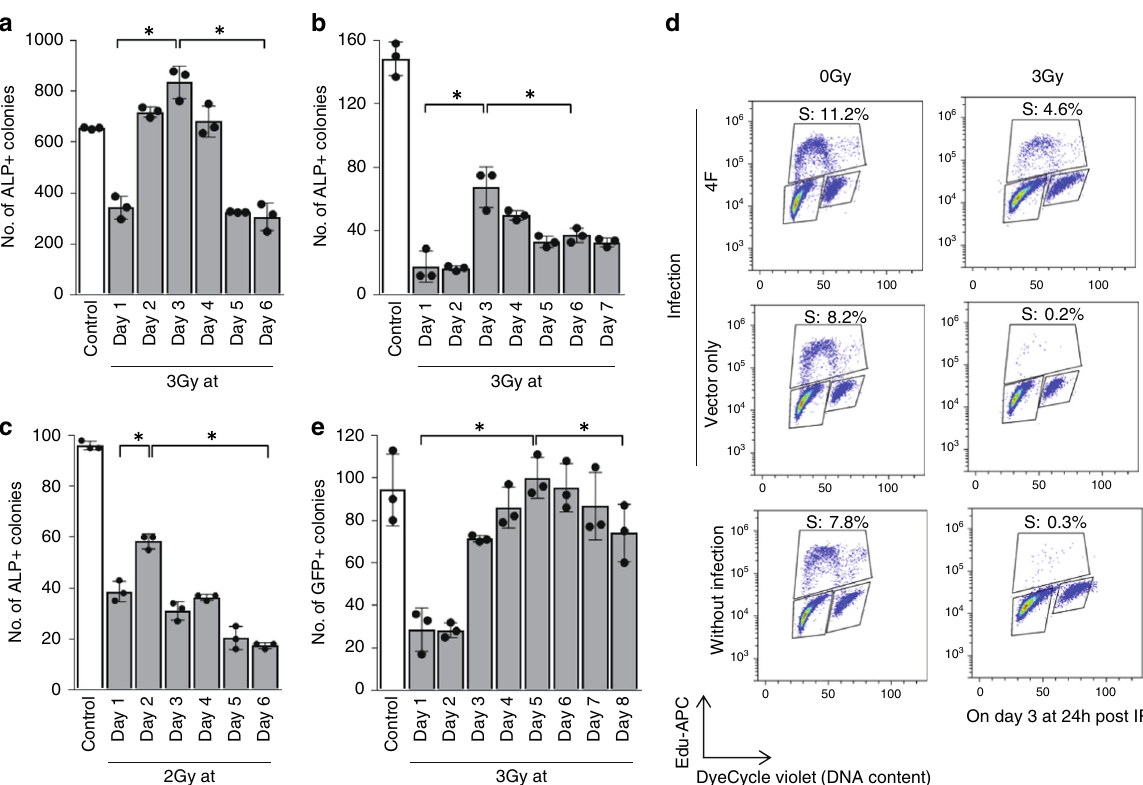
Fig. 4 Veri fi cation of stage-speci fi c radio-resistance in iPSCs generated using different systems. a Dox-induced MEFs were exposed to a 3 Gy dose of X-ray irradiation on days 1 – 6 and ALP + colonies were counted on day 12 (Supplementary Fig. 6 culture condition [4]) (means ± SD, n = 3 independent dishes). Results are representative of two independent experiments with three replicates per group. Similar results were also obtained using original